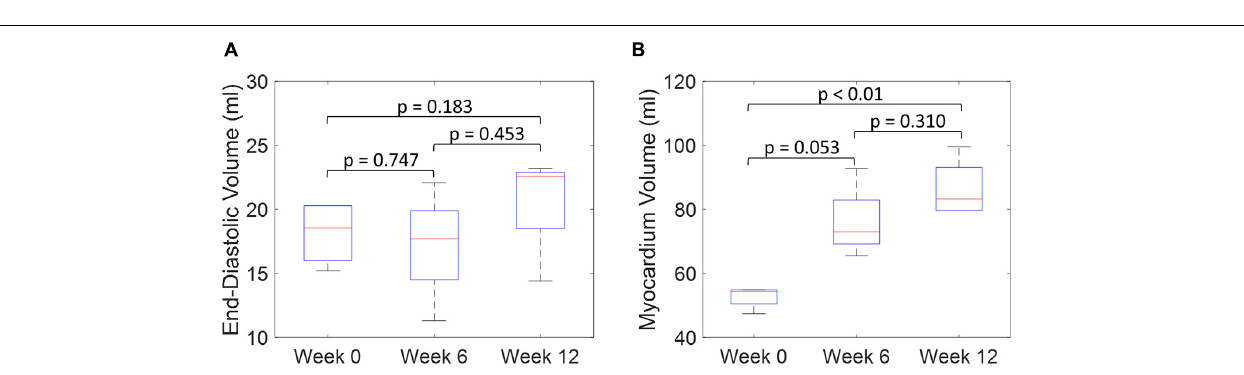
FIGURE 10 | Plots of 3D geometries and 2D LV contours to compare the predicted and targeted LV geometries of exercised animals at week 12.